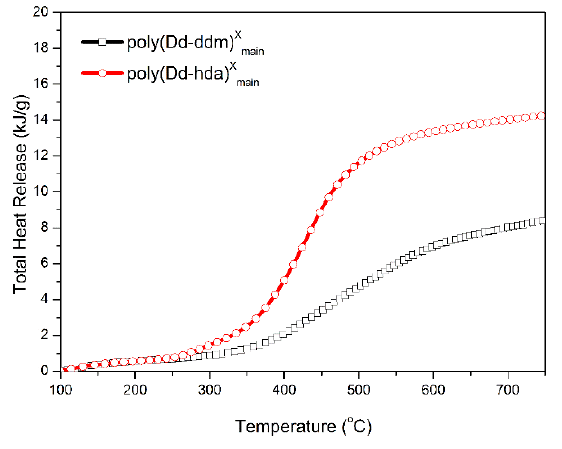
Figure 8. Heat release rate (HRR) versus temperature for poly(Dd-hda) Xmain and poly(Dd-ddm) Xmain .